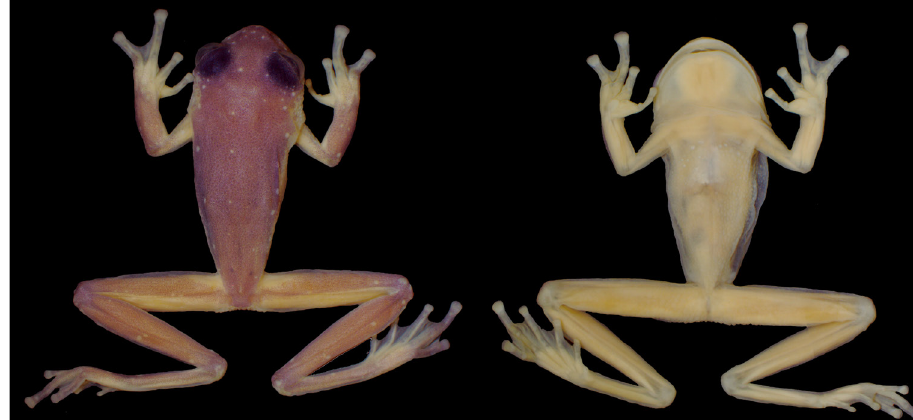
Figure 1. Teratohyla midas (MNRJ 23856). SVL 19.5